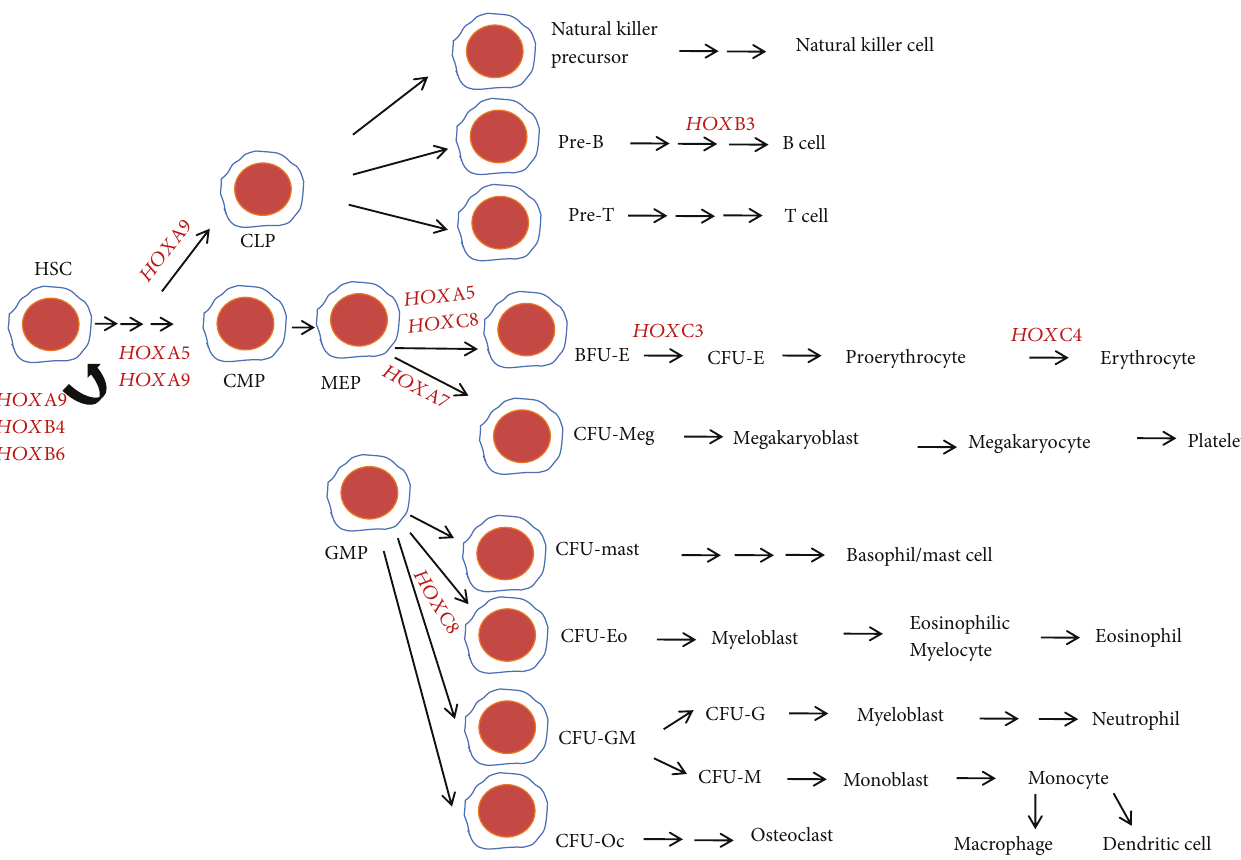
Figure 2: HOX gene expression during hematopoiesis. The hematopoietic stem cell (HSC) is a multipotent stem cell that has the ability to give rise to common lymphoid progenitor (CLP) and common myeloid progenitor (CMP) cells. HOXA9 , HOXB4 , and HOXB6 are known to be expressed in HSC and regulate HSC self-renewal. HOXA5 and HOXA9 are involved in the proliferation and di ff erentiation of HSC to CMP, and HOXA9 regulates the di ff erentiation of HSC into CLP. HOXB3 is expressed during the di ff erentiation of pre-B cells into B cells. HOXA5 and HOXC8 are expressed during erythroid di ff erentiation of megakaryocyte-erythrocyte progenitors (MEP) whereas HOXA7 is expressed during megakaryocyte di ff erentiation. HOXC3 and HOXC4 are crucial during erythroid lineage di ff erentiation. HOXC8 is shown to play a regulatory role during the di ff erentiation of granulocyte-monocyte progenitor (GMP) cells. HSC: hematopoietic stem cells; CMP: common myeloid progenitor; CLP: common lymphoid progenitor; MEP: megakaryocyte-erythrocyte progenitor; GMP: granulocyte-monocyte progenitor; BFU-E: erythroid burst-forming units; CFU-E: erythroid colony-forming unit; CFU-Meg: megakaryocyte colony-forming unit; CFU-mast: mast colony-forming unit; CFU-Eo: eosinophil colony-forming unit; CFU-GM: granulocyte-monocyte colony-forming unit; CFU-Oc: osteoclasts colony-forming